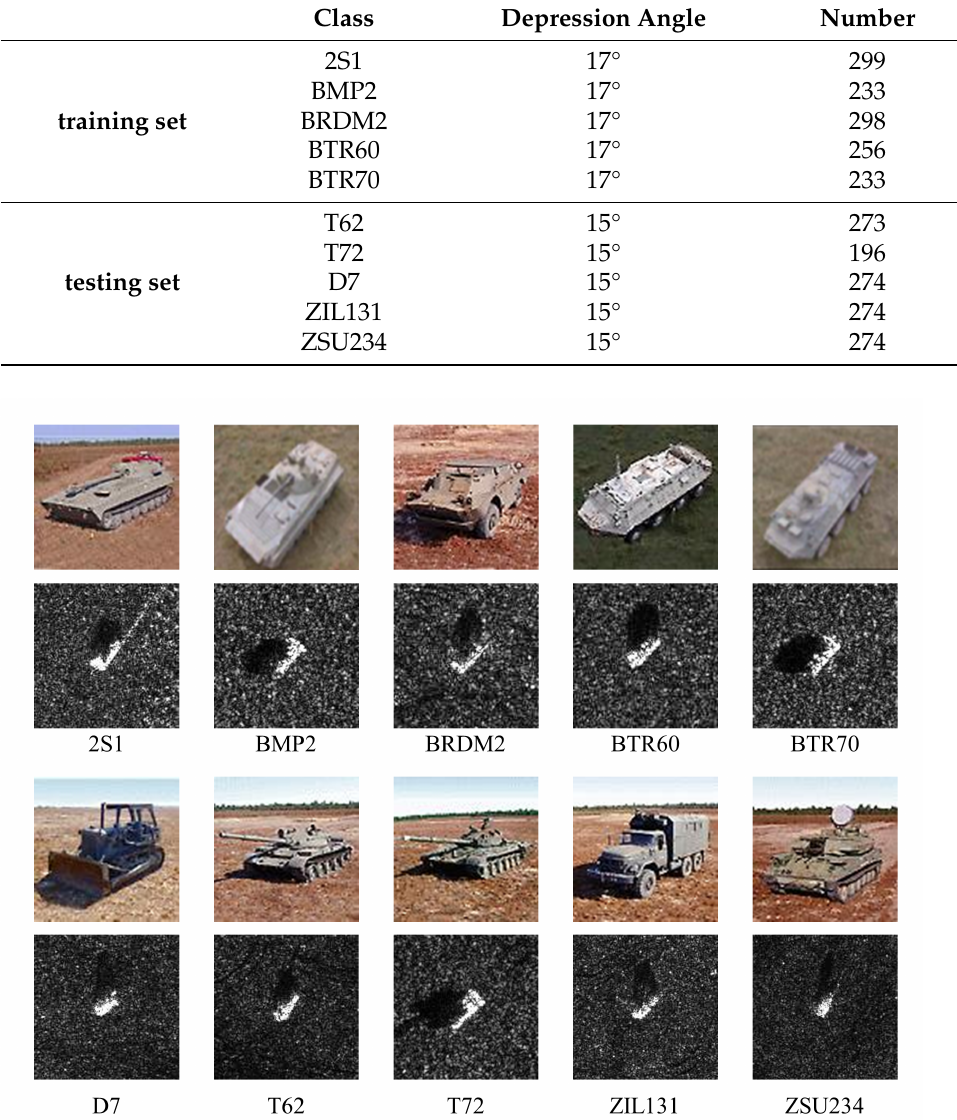
Figure 5. Optical and SAR images of 10 vehicles in MSTAR